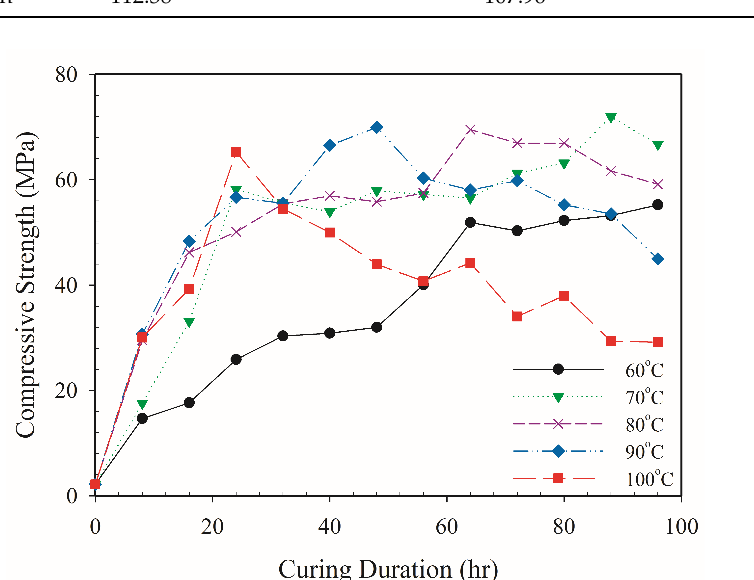
Figure 2. Variations with curing duration in the 4-day compressive strength of geopolymer specimens at various curing temperatures when AE% = 1%.